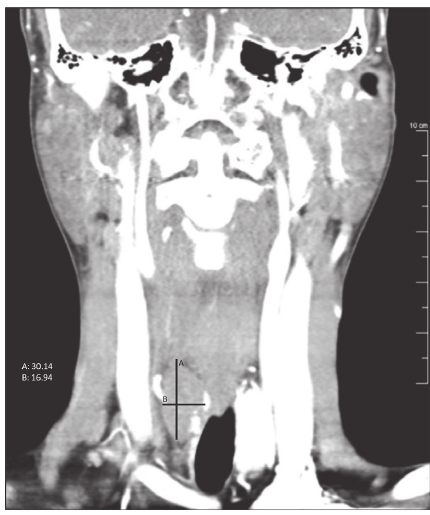
Figure 1: Coronal CT-neck with contrast demonstrates a 30.1mm × 16.9mm right-sided parathyroid adenoma causing mass effect.